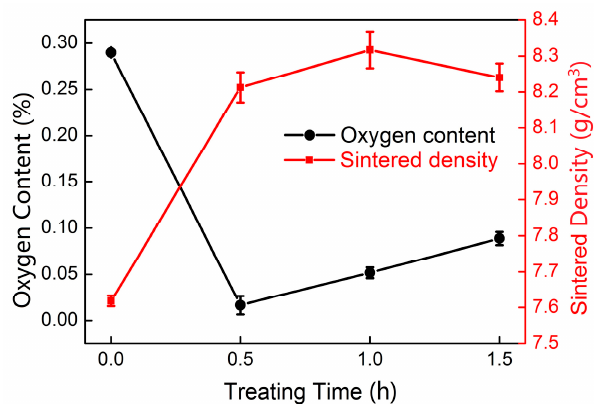
Figure 6. Oxygen contents and sintered density of Cu-0.5 wt.% TiH 2 samples treated at 650 °C for different time.